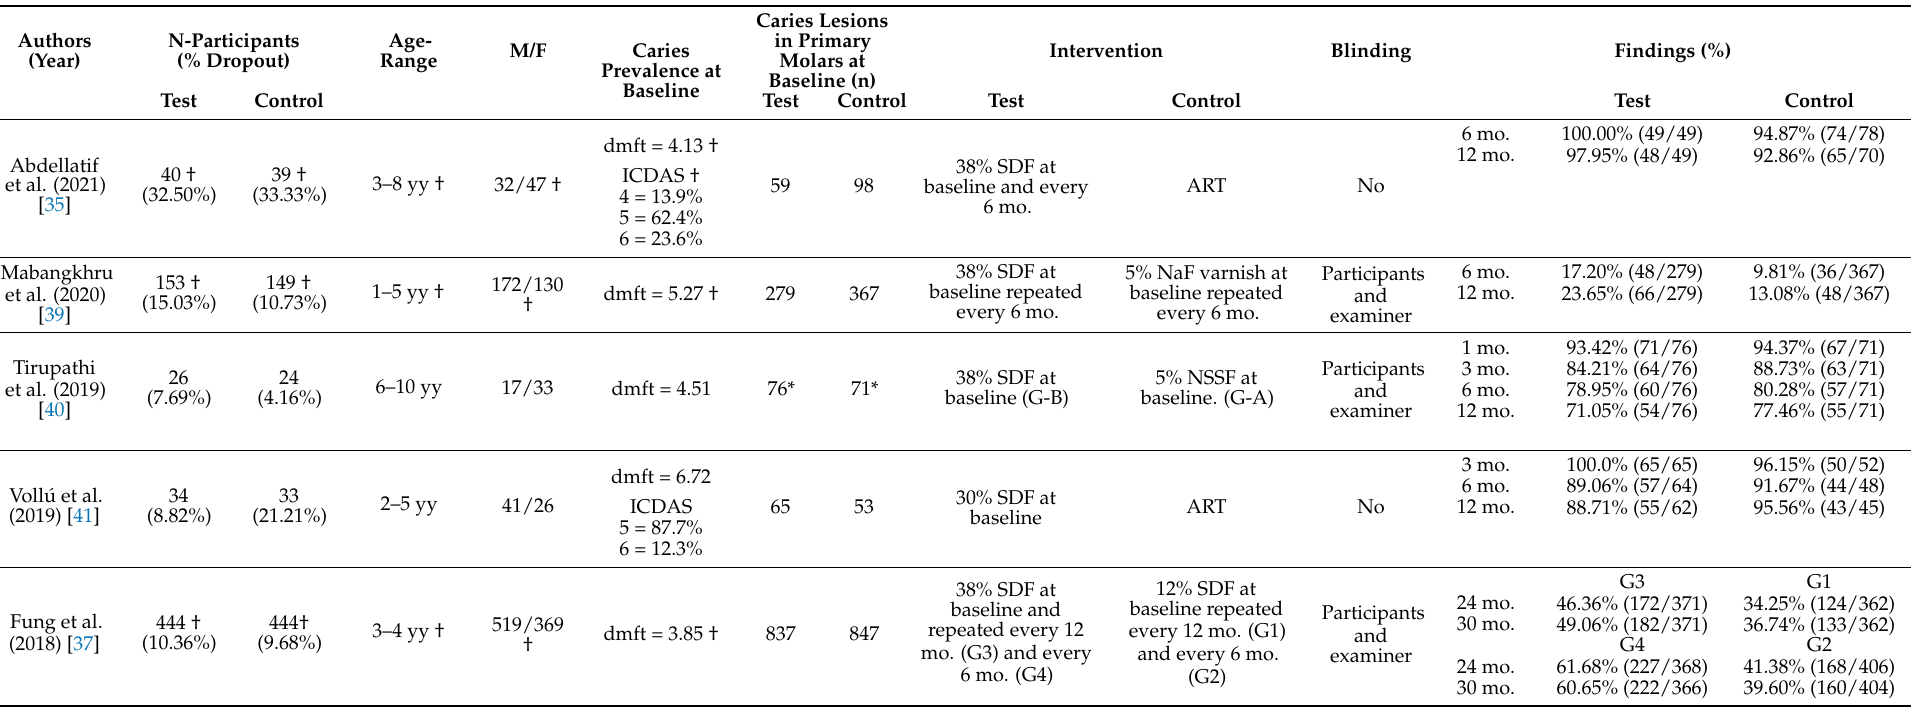
Table 2. Main characteristics of the studies included in meta-analysis (results rounded up to 1 decimal when 2 decimals were not